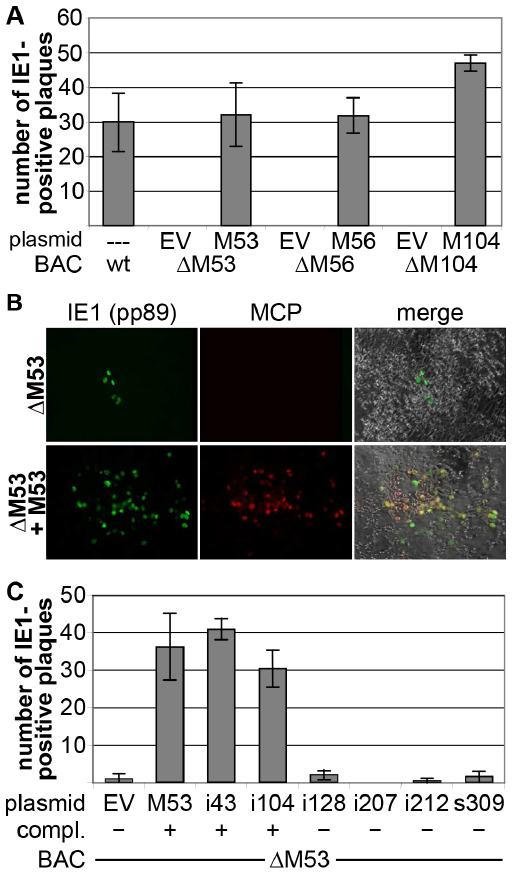
Figure 3. Verification of the cell-based complementation assay. (A) Flpe-NIH were nucleofected with the indicated BACs and plasmids and mixed with NIH/3T3. Samples were fixed at 6 dpt, stained with an antibody specific for the IE1 protein and IE1-positive plaques quantified. Depicted are average and SD of triplicate samples of two independent experiments. EV, empty vector. (B) Flpe-NIH were treated as in (A), stained with antibodies specific for the IE1 (pp89) and the major capsid protein (MCP) and images taken using a fluorescence microscope. (C) Flpe-NIH were nucleofected with the D M53 BAC and a rescue plasmid expressing the indicated M53 mutants and treated as in (A). Depicted are mean and SD of duplicates of two experiments. Mutants were generated by transposon-based random mutagenesis and described in [33]. Their capacity to complement the loss of the wt pM53 protein is indicated below the diagram. EV, empty vector; i, insertion of five amino acids; s, stop mutation at this position.